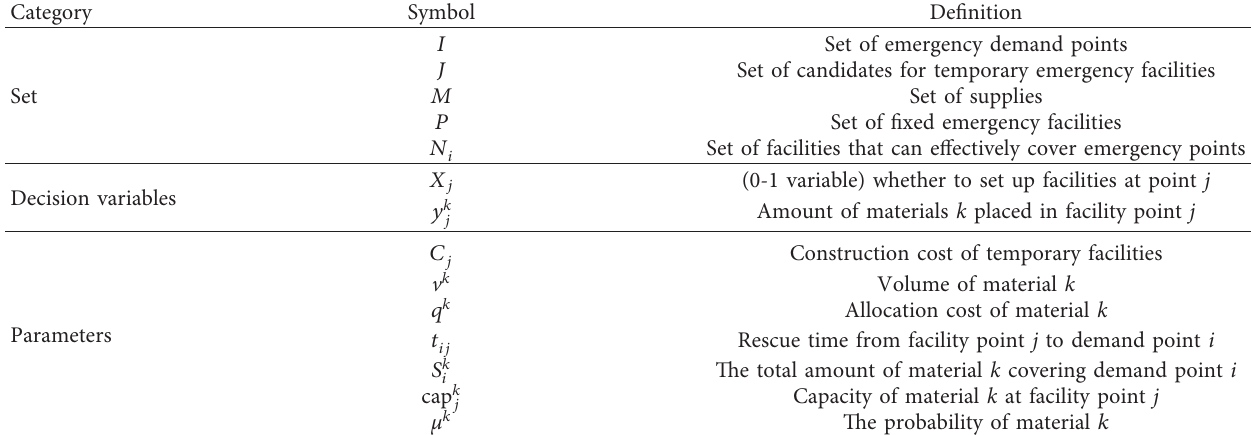
Table 2: Model parameter naming table.